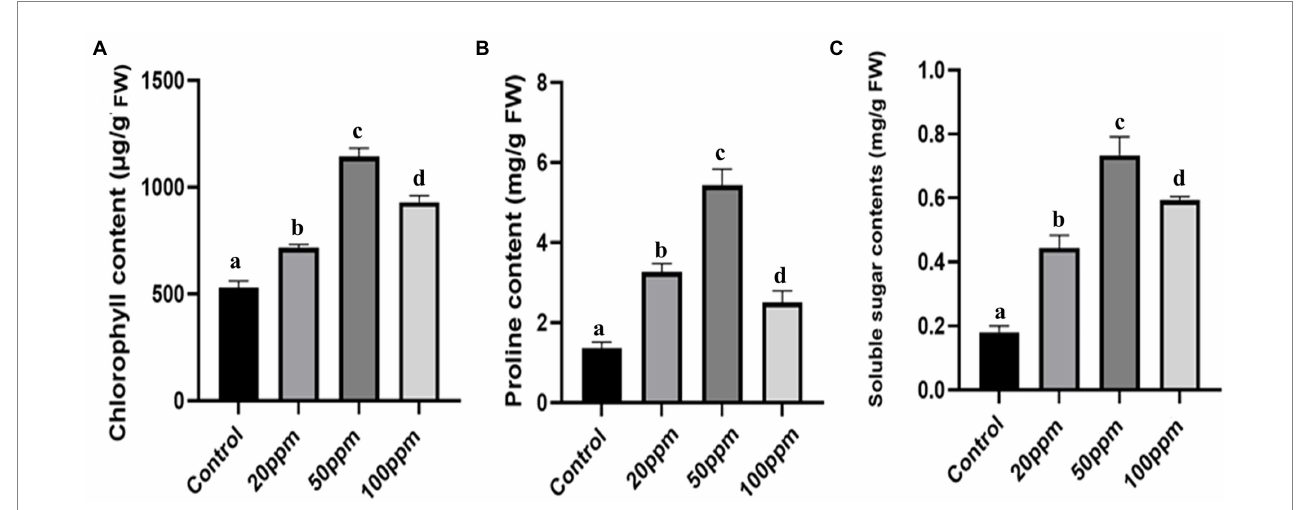
FIGURE 5 The effect of GRH foliar spray (20, 50, and 100 ppm) on chlorophyll content (A) , soluble sugar content (B) , proline content (C) of O. sativa ssp. indica MTU 7093 swarna in comparison to control. Values on the graphs are the means ± Standard error (SE) of three replicates. Tukey’s multiple comparison test was performed. The letters a, b, c, and d indicate significant differences compared to the control plant (At, p <